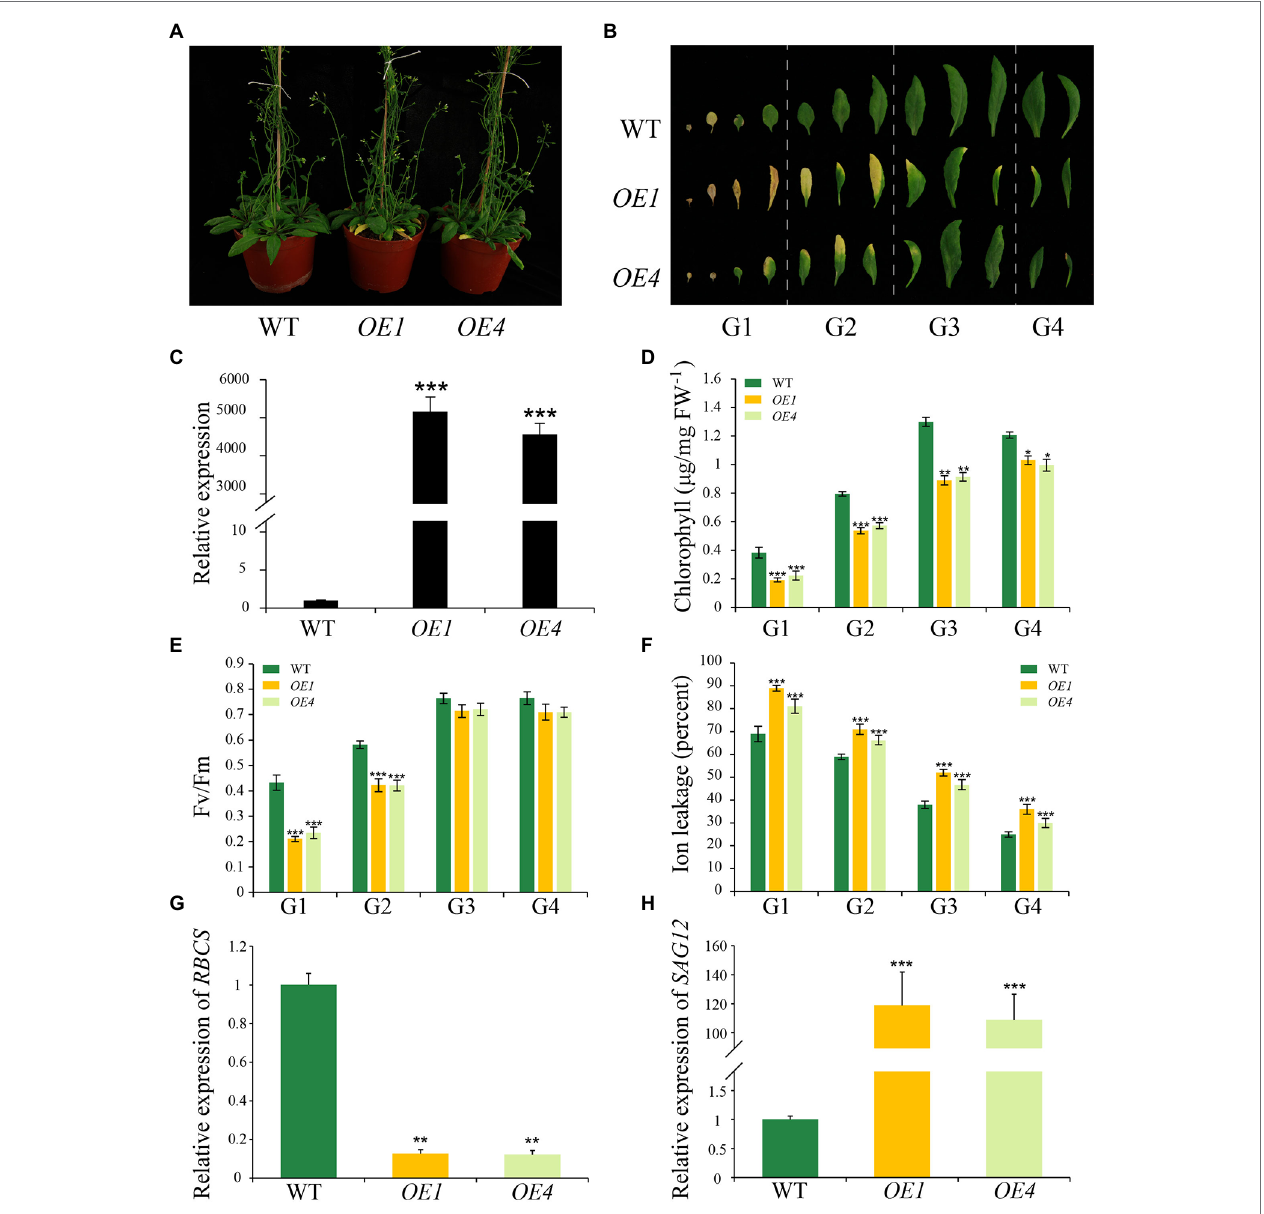
FIGURE 5 | Leaf senescence phenotypes of IDL6 overexpression plants. (A) Leaf senescence phenotypes of 6-week-old wild-type and IDL6 overexpression lines ( OE1 and OE4 ). (B) Phenotypes of 12 detached rosette leaves from wild-type and IDL6 overexpression lines. (C) Relative expression of the IDL6 gene in wild-type and IDL6 overexpression lines. Quantification of chlorophyll contents (D) , photosynthetic rates (E) and ion leakage (F) in leaves from 4 groups of rosette leaves. The relative expression of RBCS (G) and SAG12 (H) of group 2 leaves from each line. The data are means ± SD of three biological repeats. Significant differences (* p < 0.05, ** p < 0.01, and *** p < 0.001) compared with the wild type in each group were determined by Student’s t